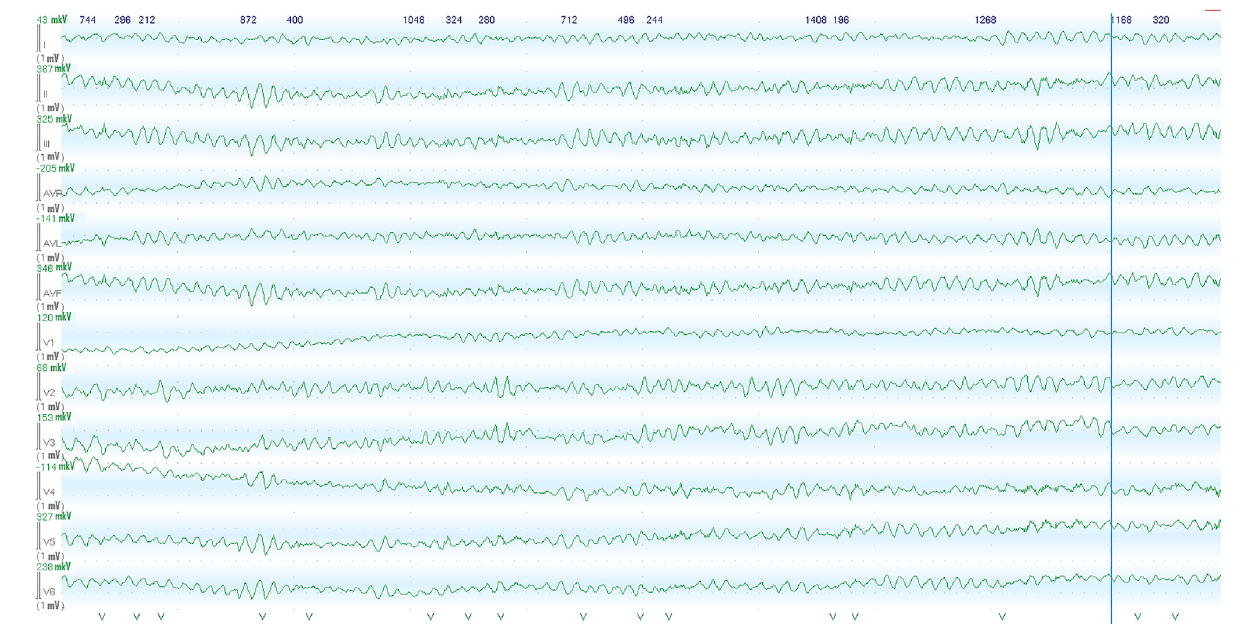
FIGURE1| Images recordedbytheECG monitoringsystem intheintensivecareunit within the fi rsthour after theinitial out-of-hospitalepisodeofabortive sudden cardiac death. Ventricular fi brillation was recorded from patients, following admission to cardiac